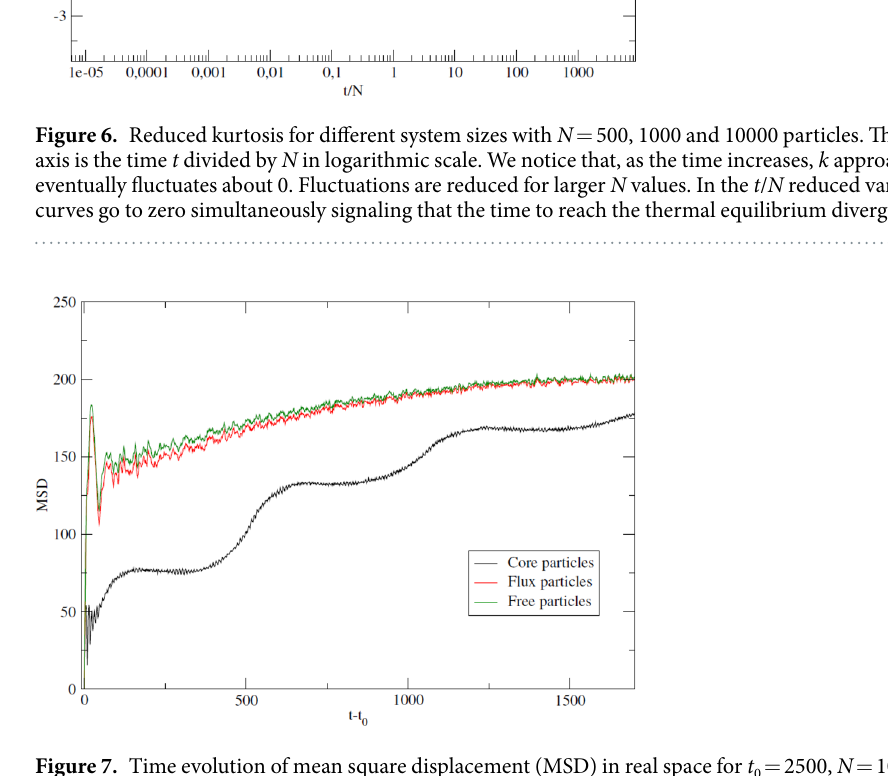
Figure 7. Time evolution of mean square displacement (MSD) in real space for t 0 = 2500, N = 10 4 particles and n = 10. The graph shows the diffusion regime for the three types of particles: in black the LEP, in red the IEP, and in green the HEP. The IEP, which are the particles that form the flux between the cores, diffuse in the same way as the free particles, even if the IEP are trapped to the